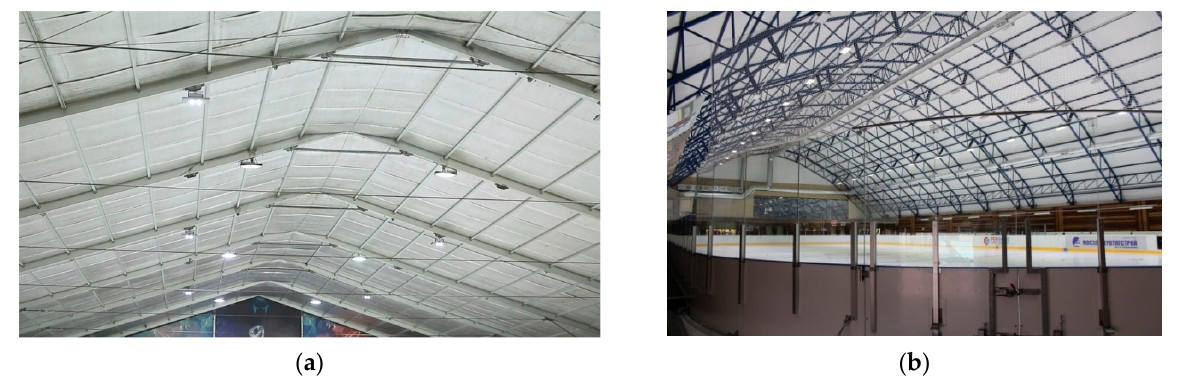
Figure 1. insulation of sports facilities: ( a ) ice rink; ( b ) ice stadium.